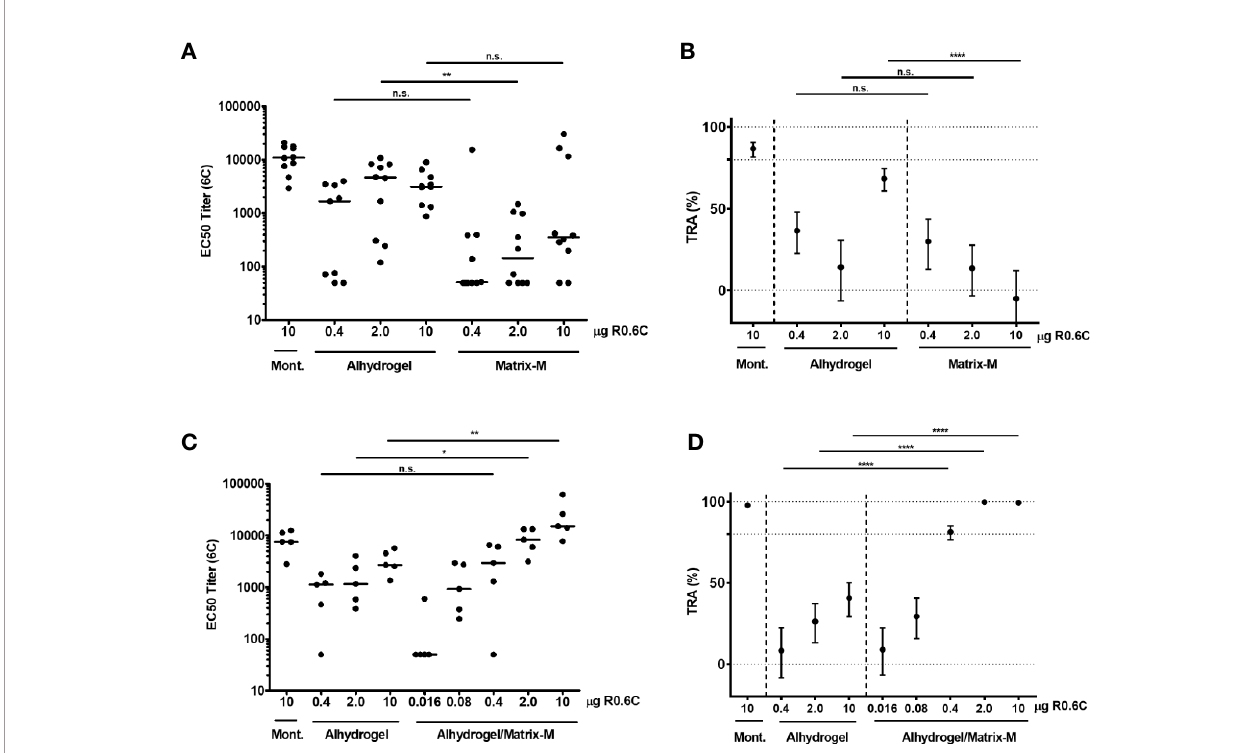
FIGURE 7 | Immunogenicity of R0.6C vaccine formulations. Two separate mice immunization experiments were conducted with R0.6C formulated with different adjuvants. In each experiment one group received R0.6C formulated with Montanide (Mont.), which has previously been shown to induce high antibody titers (20). 6C- speci fi c antibody titers for individual mice in the fi rst (A) and second (C) experiment are shown as mid-point titers. Mid-point titers below 50 are reported as 50. Bars represent median values. Statistical difference between same-dose groups is determined by Mann-Whitney test, and reported p-values are two-sided (n.s. not signi fi cant, *p < 0.05, **p < 0.01). Pooled sera from the fi rst immunization (B) and second immunization (D) were tested in Standard Membrane Feeding Assay (SMFA) at 1:9 dilution. Reported values and 95% con fi dence intervals (bars) are determined by General Linearized Mixed Models with zero-in fl ated negative binomial error structure and used oocyst count data from two independent SMFA experiments with 20 mosquitoes per condition and experiment. Transmission reducing activity is calculated by comparing to a non-serum control included in each SMFA. Statistical difference is determined between same-dose groups (n.s. not signi fi cant, ****p <